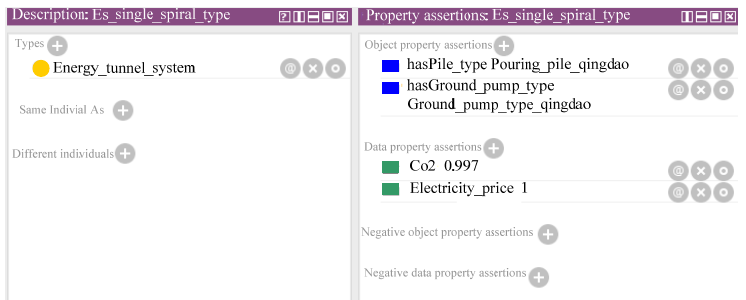
Figure 6. Creation of an instance.